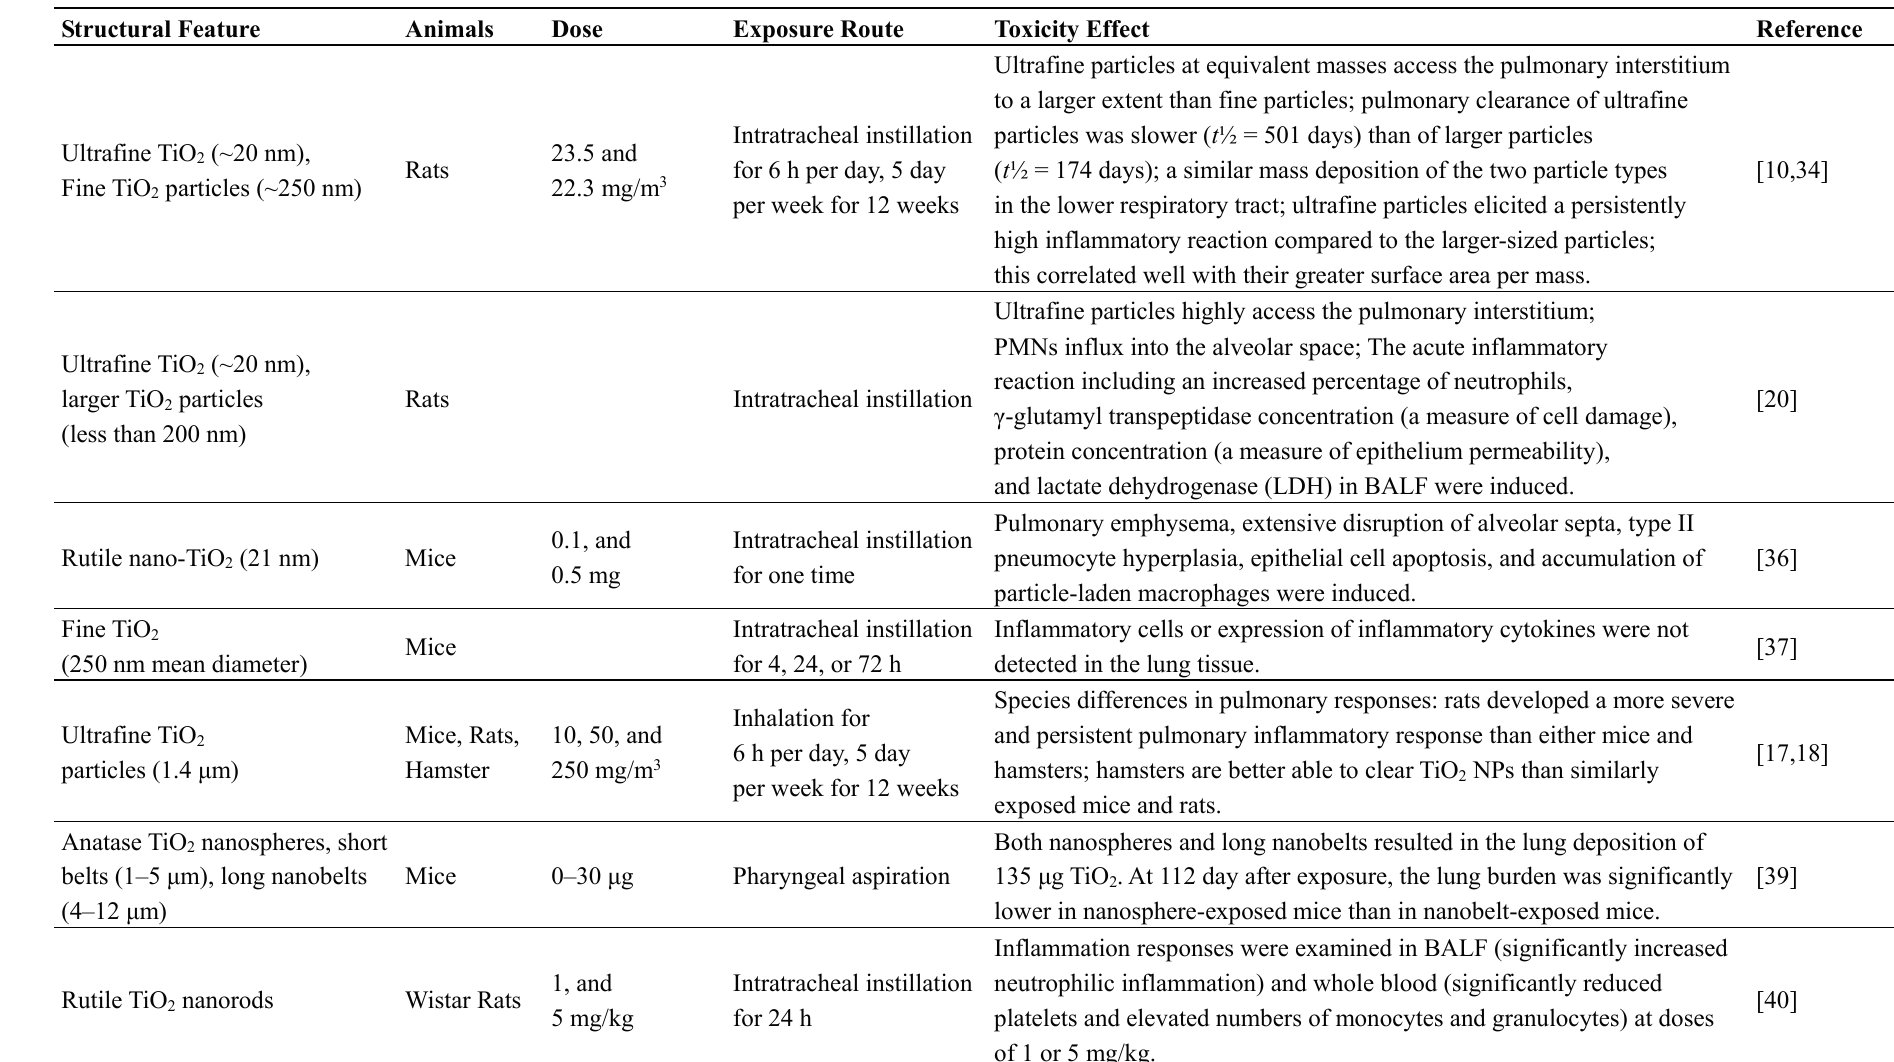
Table 1. Lung toxicity in animal models induced by different TiO 2